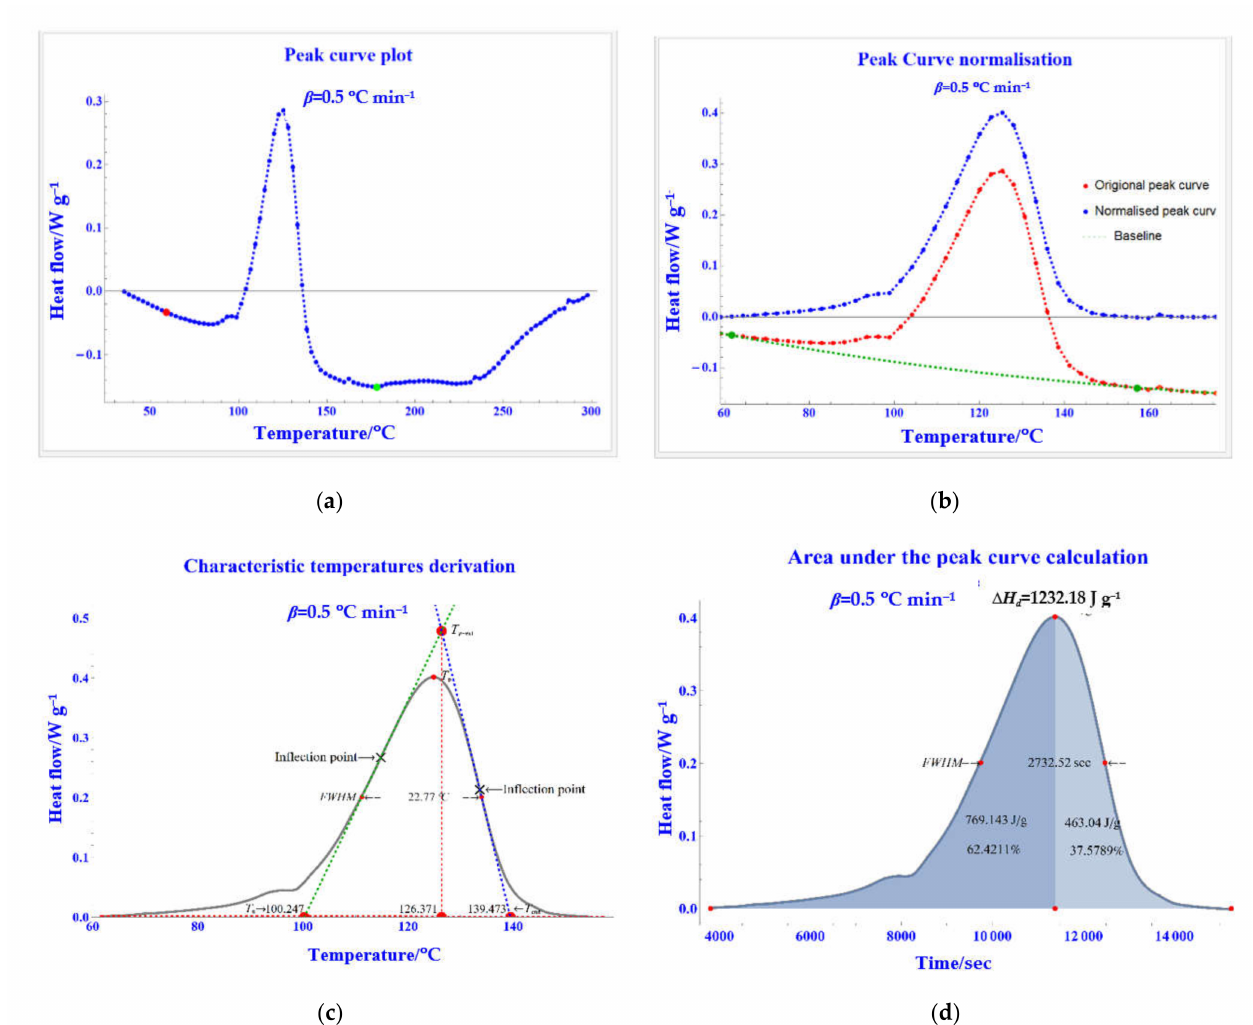
Figure 2. The procedure of DSC characteristic parameters derivation. ( a ) Peak curve recovery; ( b ) peak curve normalization; ( c ) characteristic temperature calculation; ( d ) total heat of decomposi- tion ( ∆ H d )